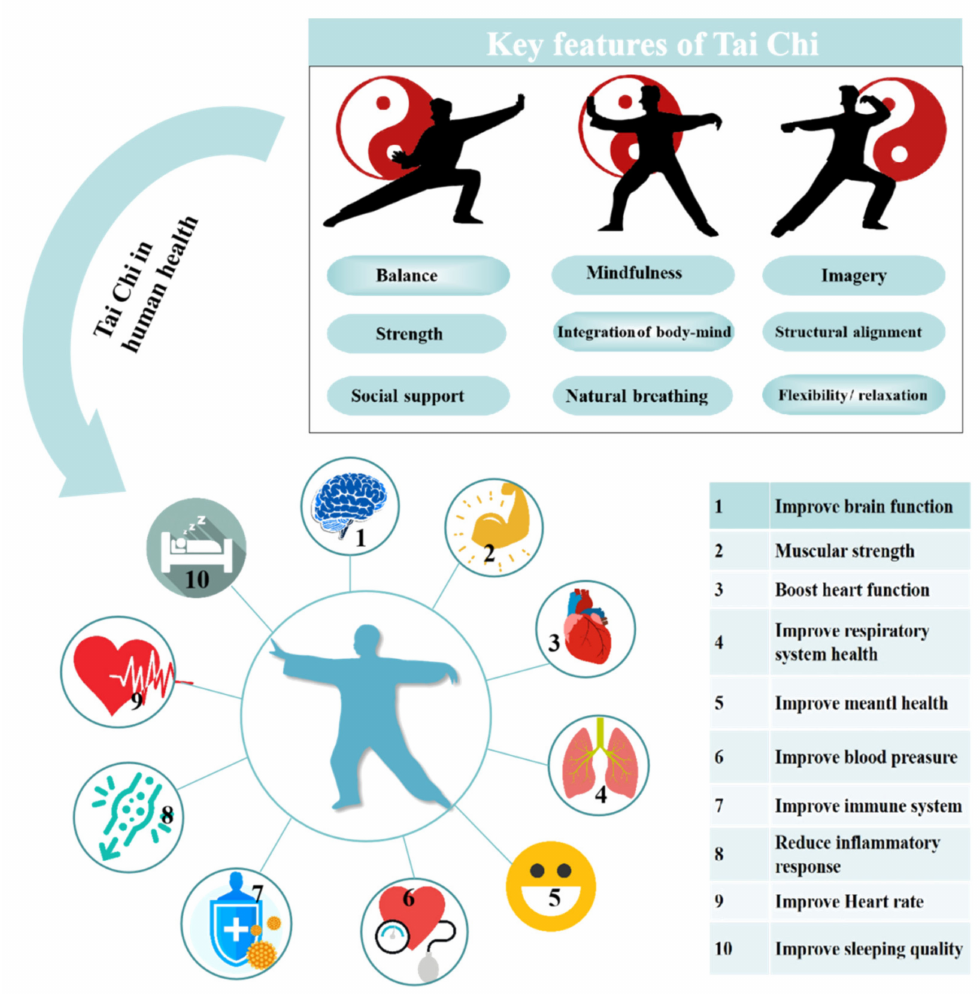
Figure 1. Key features of Tai Chi and it is influence on human